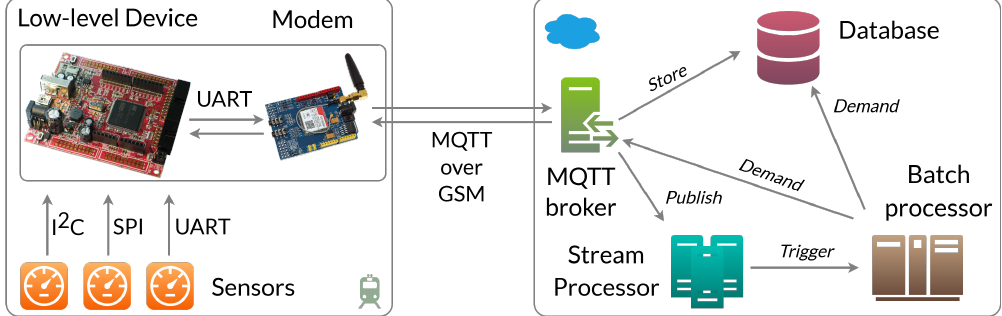
Figure 8. Architectural setup for the measurement